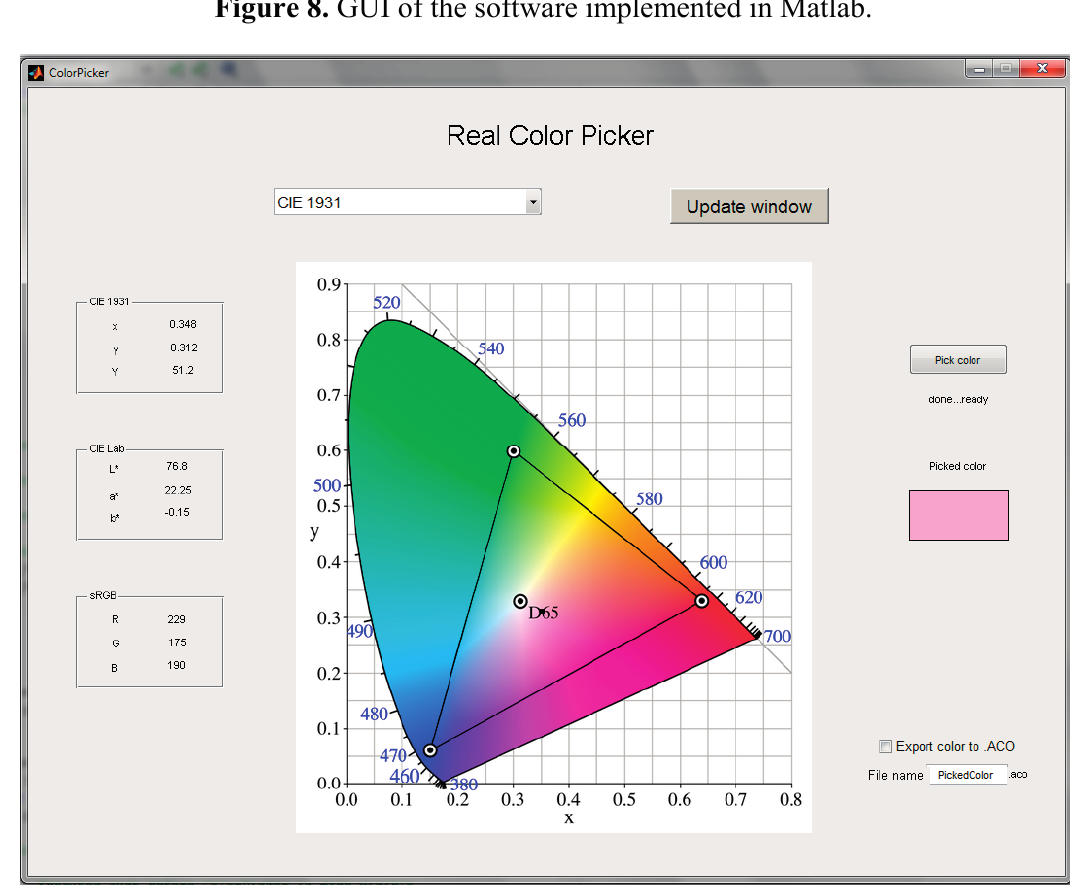
Figure 8. GUI of the software implemented in